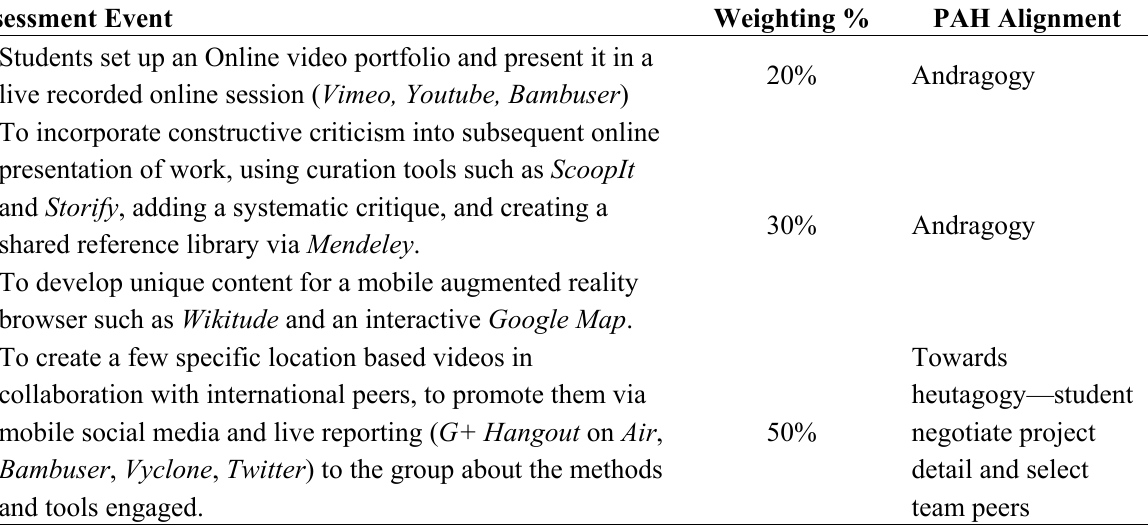
Table 7. Contextual affordances of mobile social media assessment